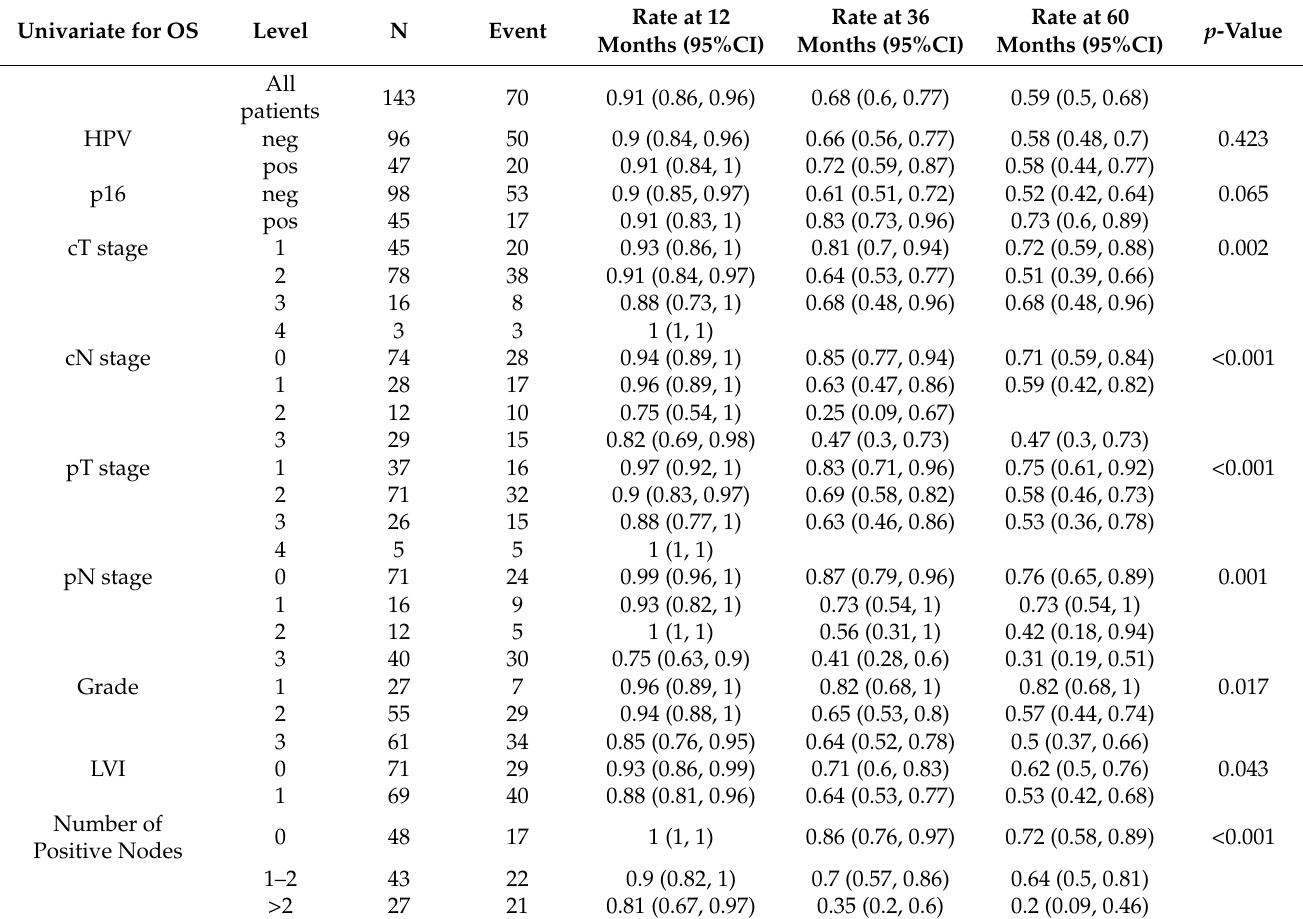
Table 2. Univariate Cox Analysis for OS at 12 months (1 yr), 36 months (3 yr) and 60 months (5 yr). HPV and p16 status and other significant patient characteristics shown.